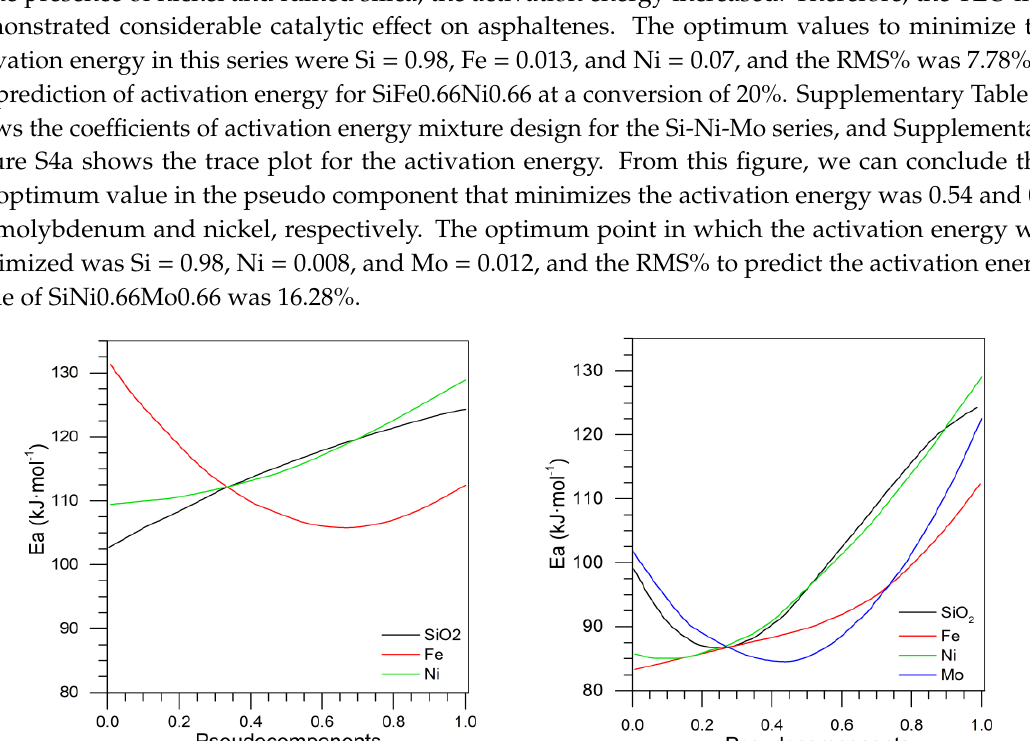
Table 8. Coefficients of activation energy mixture design for Si-Fe-Ni.